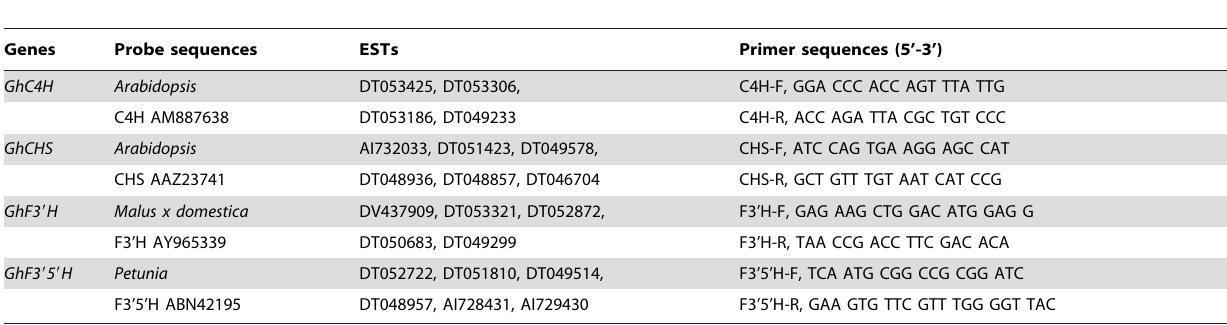
Table 1. The probe sequence, ESTs and Quantitative real-time PCR primers used in this study.